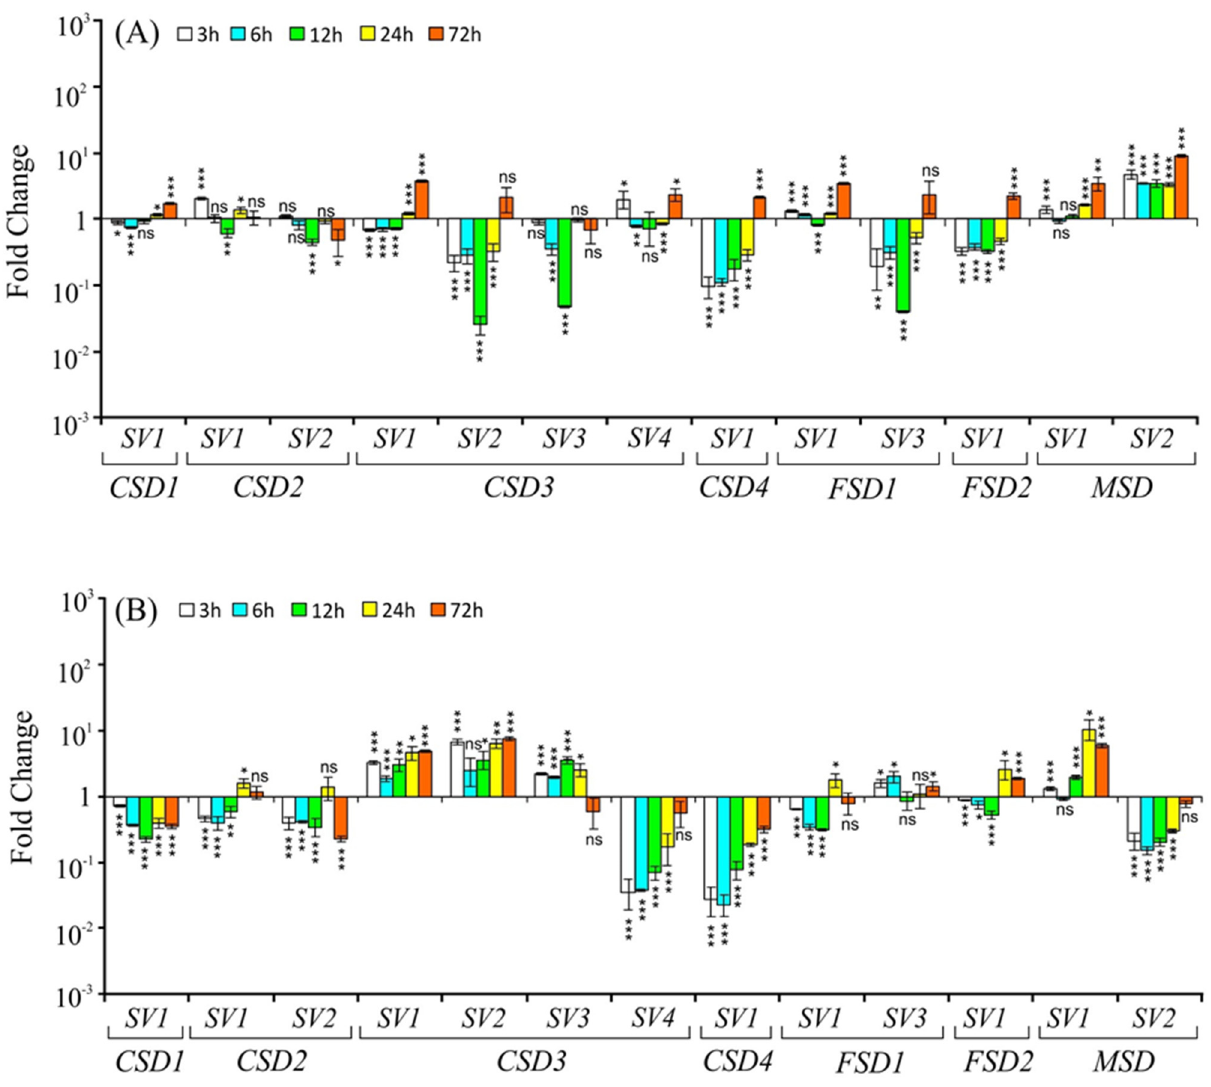
Figure 5. Relative transcript levels (on Y -axis) of CSDs , FSDs , and MSD splice variants (indicated by numbers on X -axis) in response to cold stress (4 °C), in shoot ( A ) and root ( B ) tissue at 3 h, 6 h, 12 h, 24 h, and 72 h after the stress treatment. For normalization and statistical analysis, see figure legend 3.